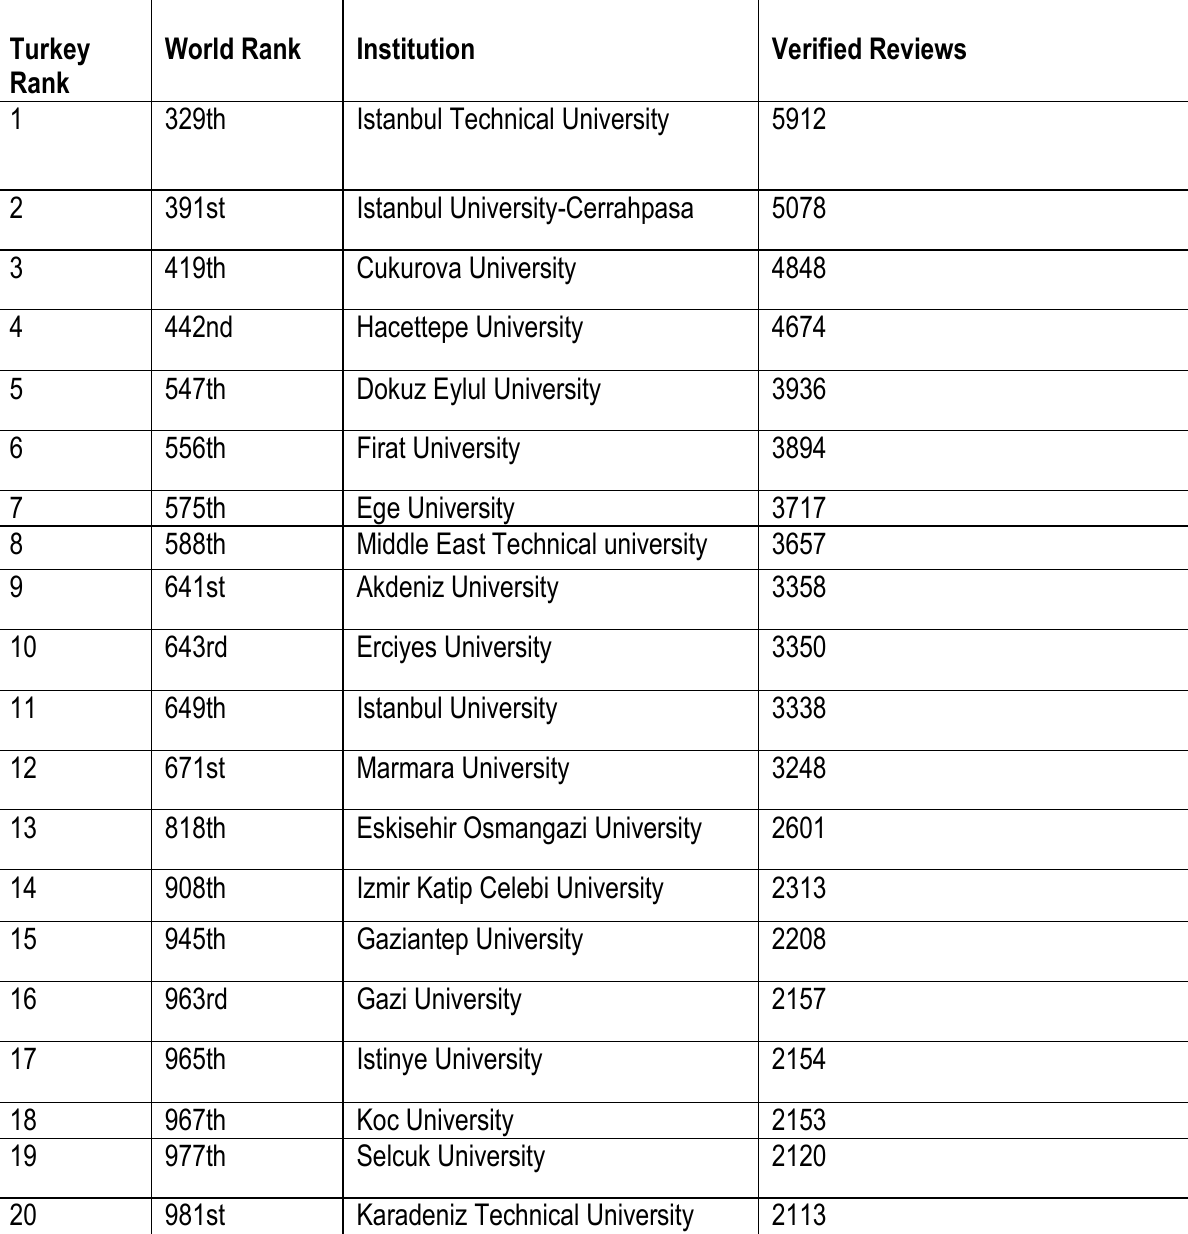
Table 5. Top 20 institutions in terms of the total number verified